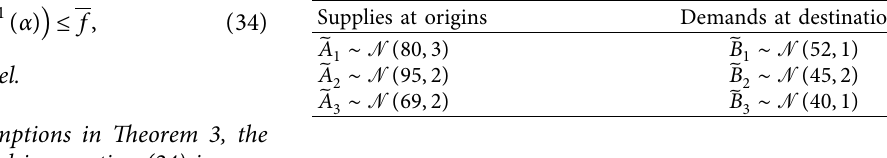
Table 2: Return rate and exchange rate.